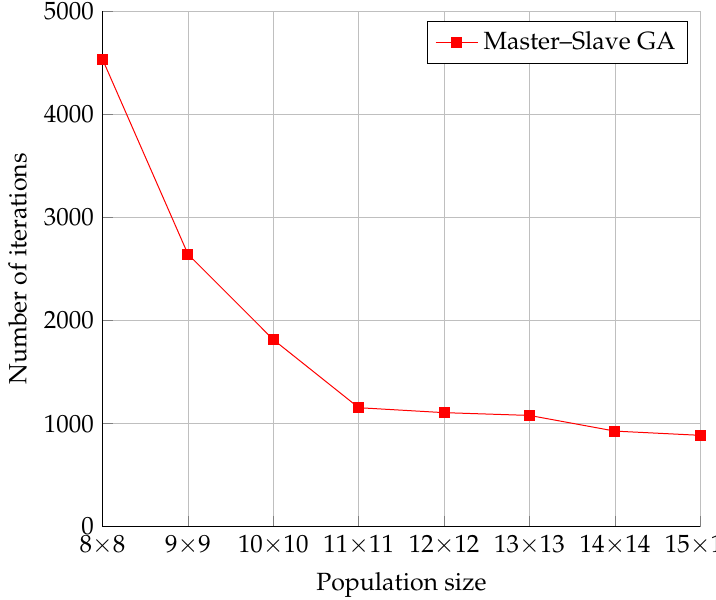
Figure 11. The number of iterations of the Serial and Master–Slave